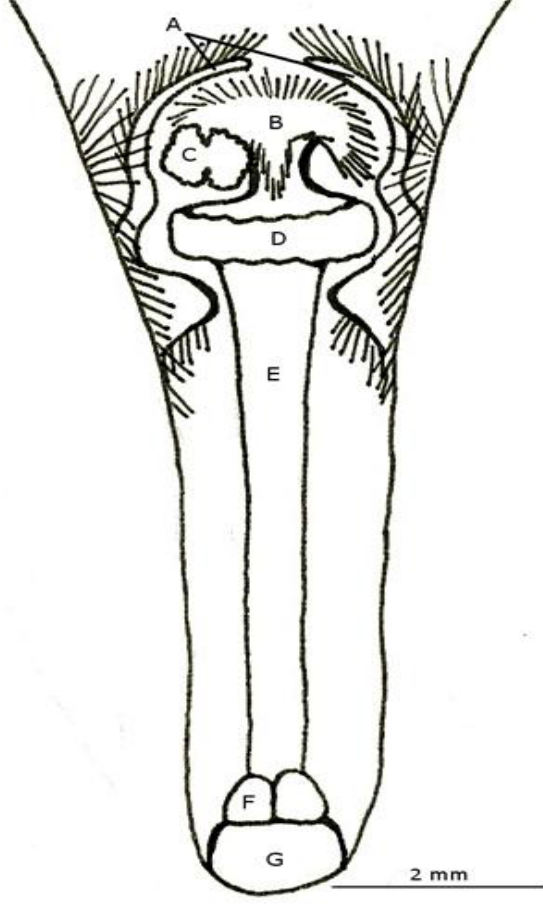
Figure 1. Internal anatomy of a Vinca flower. A - anthers; B - filament brush; C - pollen grains; D - stigmatic ‘wheel’; E - style; F - ovaries; G - receptacle bearing